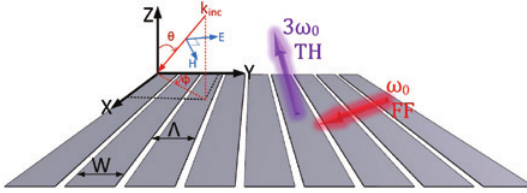
Figure 4: GNRs with period Λ and width W .